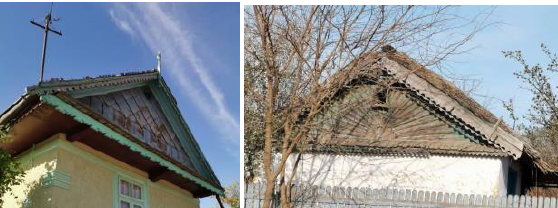
Figure 9. Gable decorated with metal shingles (left) or wood